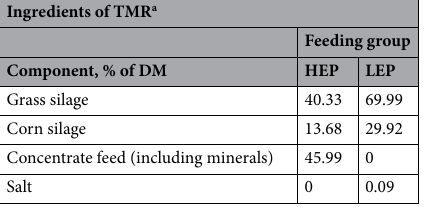
Table 1. Ingredients of total mixed rations (TMR) fed during the experimental period. a DM dry matter, HEP high energy and protein diet, LEP low energy and protein